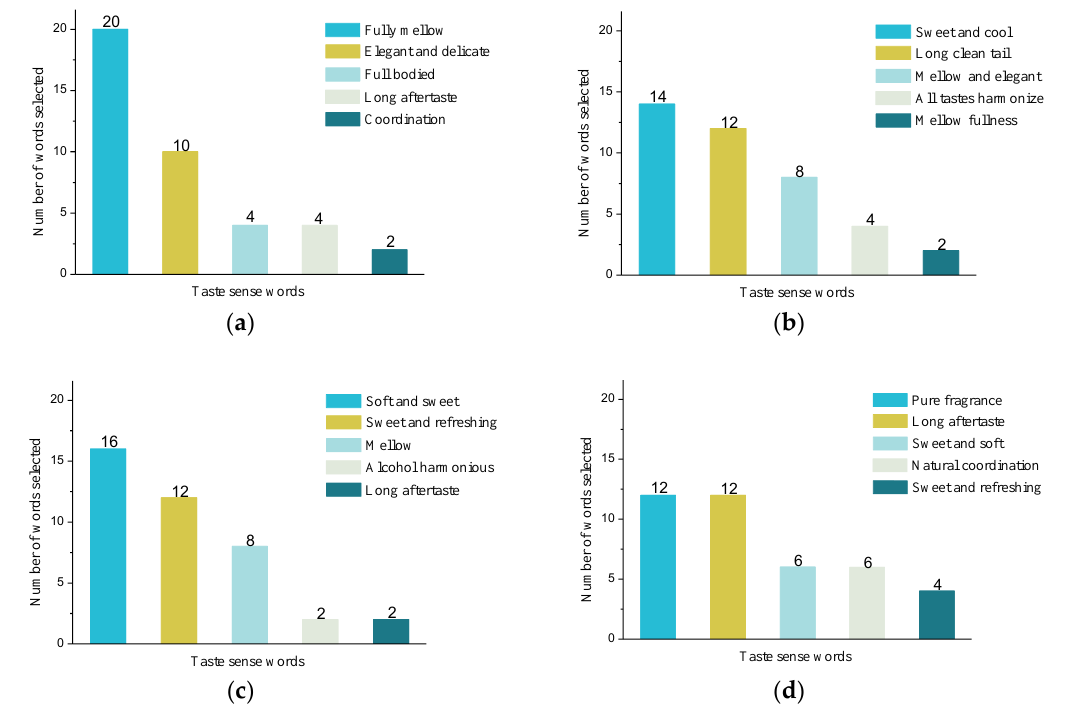
Figure 4. The proportion of liquor taste words selected by examiners: ( a ) jiang-flavor style, ( b ) feng-flavor style, ( c ) nong-flavor style, and ( d ) mild-flavor style.